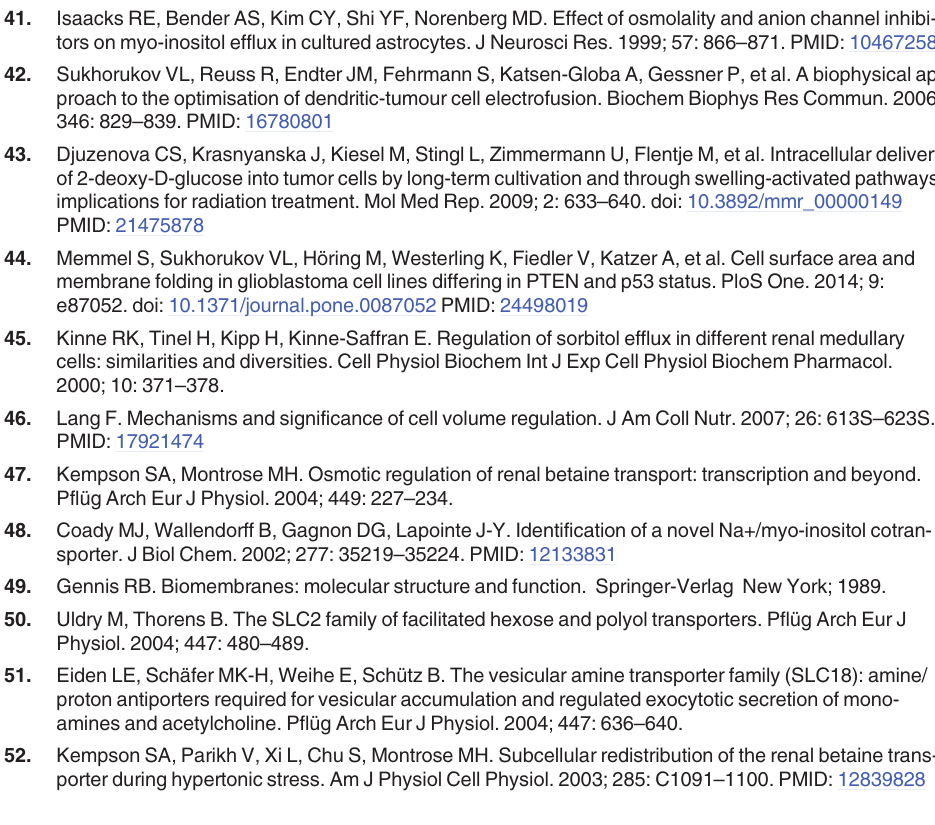
PLOS ONE | DOI:10.1371/journal.pone.0119990 March 10,